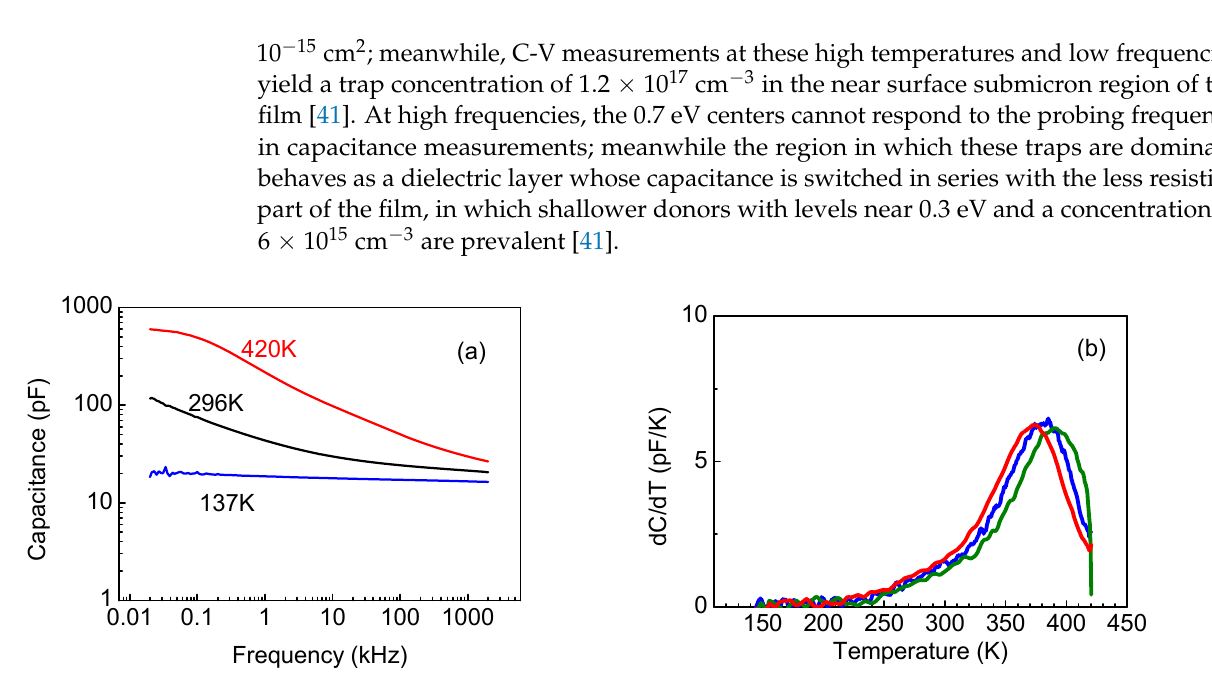
13 of 24 sub ‐ bandgap photosensitivity (keep in mind that the optical output power density for the LED with a peak photon energy of 4.8 eV (wavelength 259 nm) was only 1.2 mW/cm 2 , while for the set of LEDs used for sub ‐ bandgap excitation, the optical power density was 250 mW/cm 2 ). The spectral dependence of the reverse photocurrent at − 1 V (current un ‐ der illumination minus dark current) is shown in Figure 9b. Optical thresholds near 1.3 eV and 2.3 eV can be clearly seen. Interestingly, the photocurrent is quite pronounced in the forward direction, showing the same optical thresholds (Figure 9c).       10 -11 10 -10 10 -9 10 -8 10 -7 10 -6 10 -5 10 -4 10 -3 10 -2 10 -1 C u rr en t den s i t y ( A / c m 2 ) (c ) Figure 9. ( a ) I ‐ V characteristic in the dark, with 365 nm LED illumination, and 259 nm LED illu ‐ mination; ( b ) reverse photocurrent spectrum at − 1 V; ( c ) forward photocurrent spectrum at 2 V. The capacitance versus frequency C ‐ f dependencies at room temperature, 420 K, and